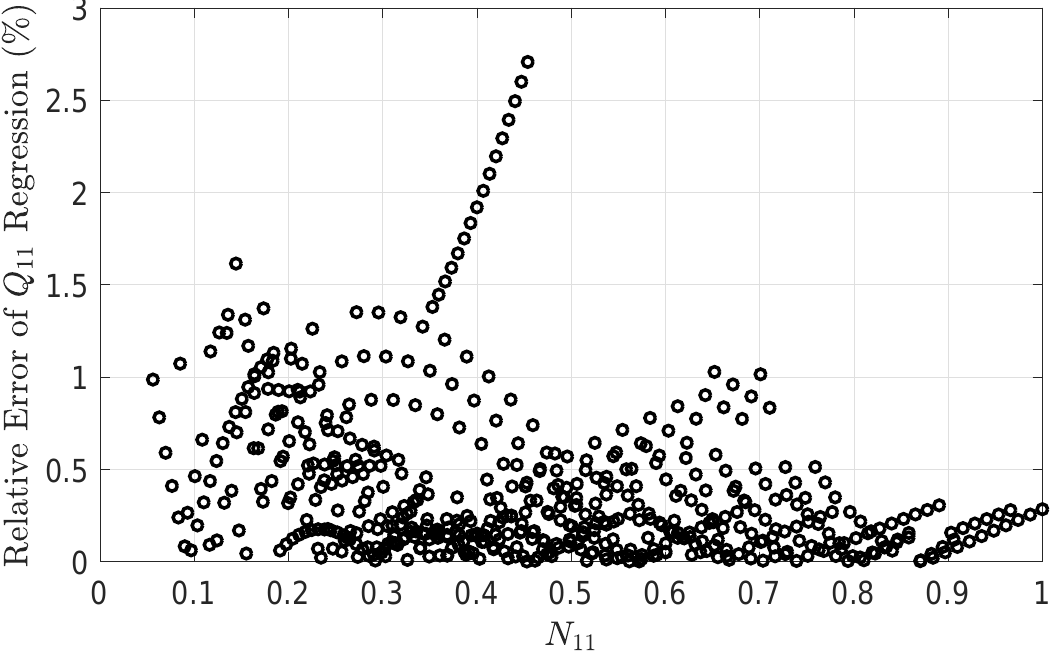
Figure 5. Relative error of Q 11 regression